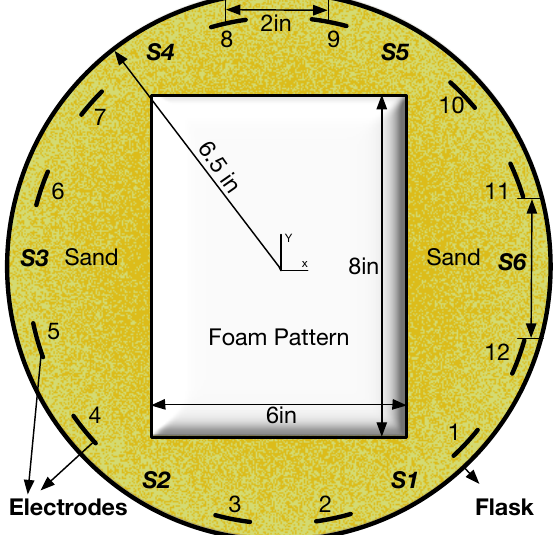
Figure 1. An ECT system for imaging conductive